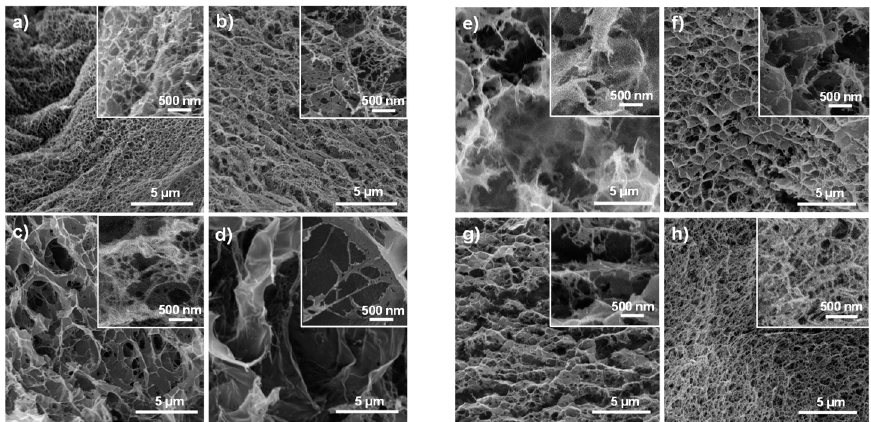
Figure 8. SEM images displaying the different morphological aspects of cellulose based systems cured under different conditions: ( a – d ) G600, CG601, CG602 and CG603, respectively; ( e – h ) G230, CG231, CG232 and CG 233, respectively. A higher magnification is included in the top right corner of each image.